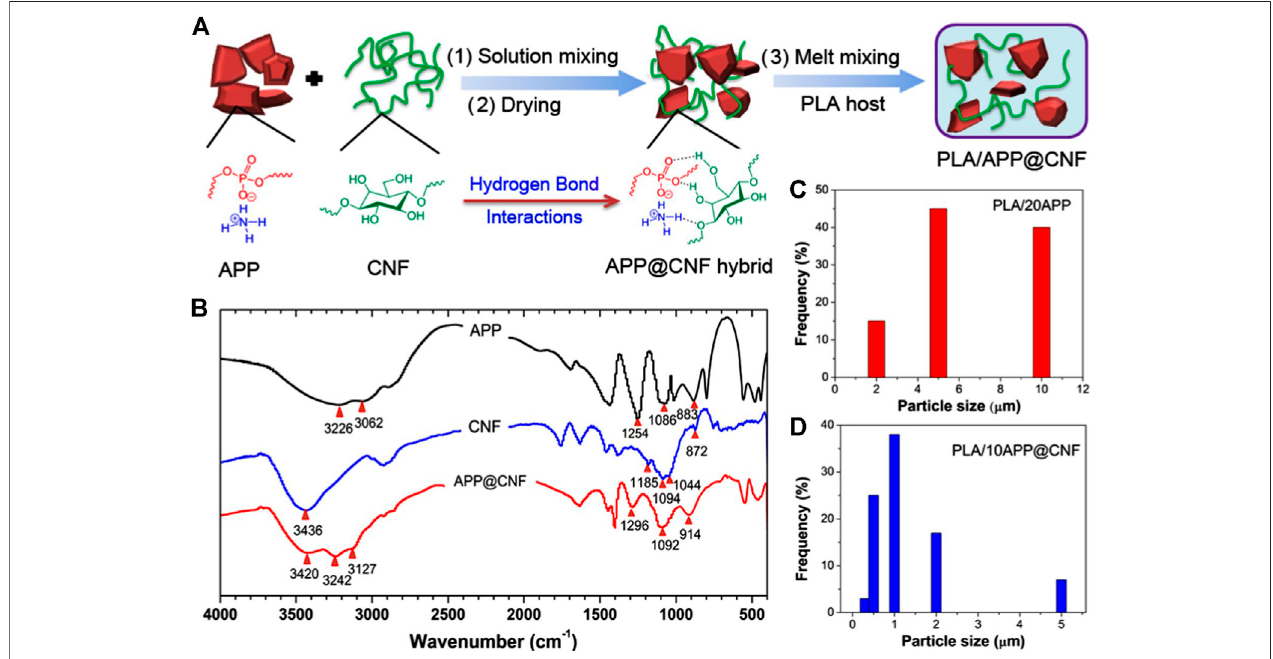
FIGURE 10 | (A) The design and preparation of both APP@CNF and its PLA composite, (B) Fourier transform infrared spectroscopy (FTIR) spectra of APP, CNF, and APP@CNF, and the weight – average particle size distribution of (C) 20% APP and (D) 10% APP@CNF in the PLA matrix (Yin et al., 2018).